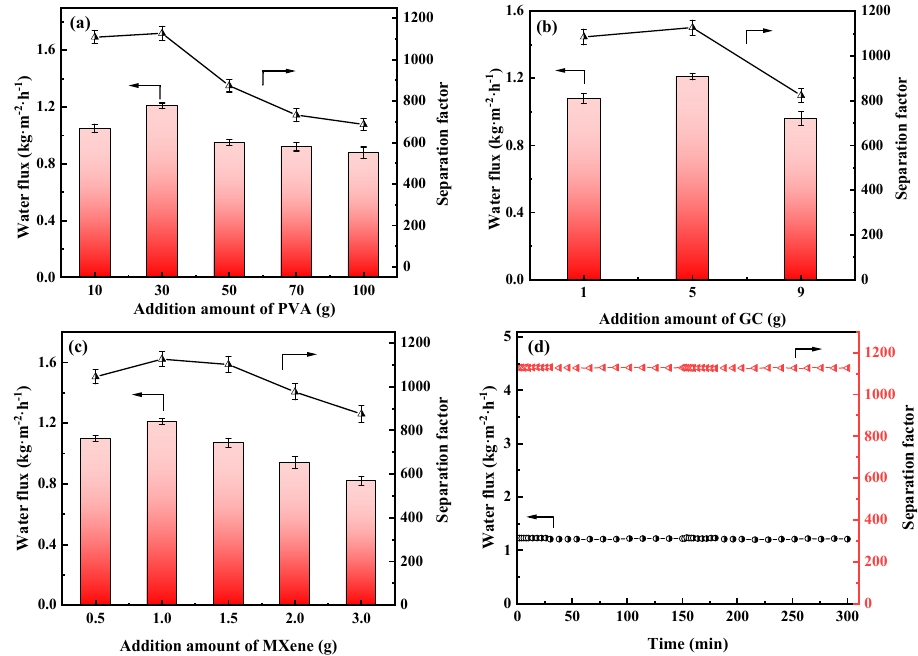
Figure 11. Water flux and separation factor of the PVA MMMs with different addition amount of the ( a ) PVA, ( b ) GC and ( c ) MXene, ( d ) long-term stability of the PGM-0 composite membrane. As shown in Figure 11a, water fl ux and separation factor of the PGM series MMMs were all increased, then decreased as the PVA addition amount increasing. When the PVA addition was 10 g (PGM-1), the GC amount was excessive, leading to the over-crosslink of the PVA molecular chains. Hence the PV performance was limited. When the PVA content was higher than 30 g, the PV performance of the PGM MMMs were decreased instead, which was ascribed to the increasing membrane thickness and the decreasing membrane crosslinking degree. Low GC content led to low crosslinking degree of the PVA membrane matrix, while high GC content caused over-crosslink of the PVA membrane matrix, as shown in Figure 11b. Therefore, the best PVA content and GC addition amount were 30 g and 5 g in this study. As for the MXene, the nanosheets greatly improved the hydrophilic- ity of the PVA-based membrane matrix, inducing the performance enhancement during the PV process. However, the overloaded MXene nanosheets agglomerated in the mem- brane matrix, resulting in a decrease in the water fl ux and separation factor. Hence, in Figure 11c, water fl ux and separation factor both declined when the MXene loading was over 1.0 g. After careful analysis of Figure 11a–c, it was concluded that the most popular MMM was PGM-0 composite membrane. As a result, long-term PV test was conducted for the PGM-0. In Figure 11d, water fl ux and separation factor, that kept stable in 300 h of the PV test, were 1.2 kg·m 2 ·h − 1 and 1120, respectively, indicating that the fabricated PGM-